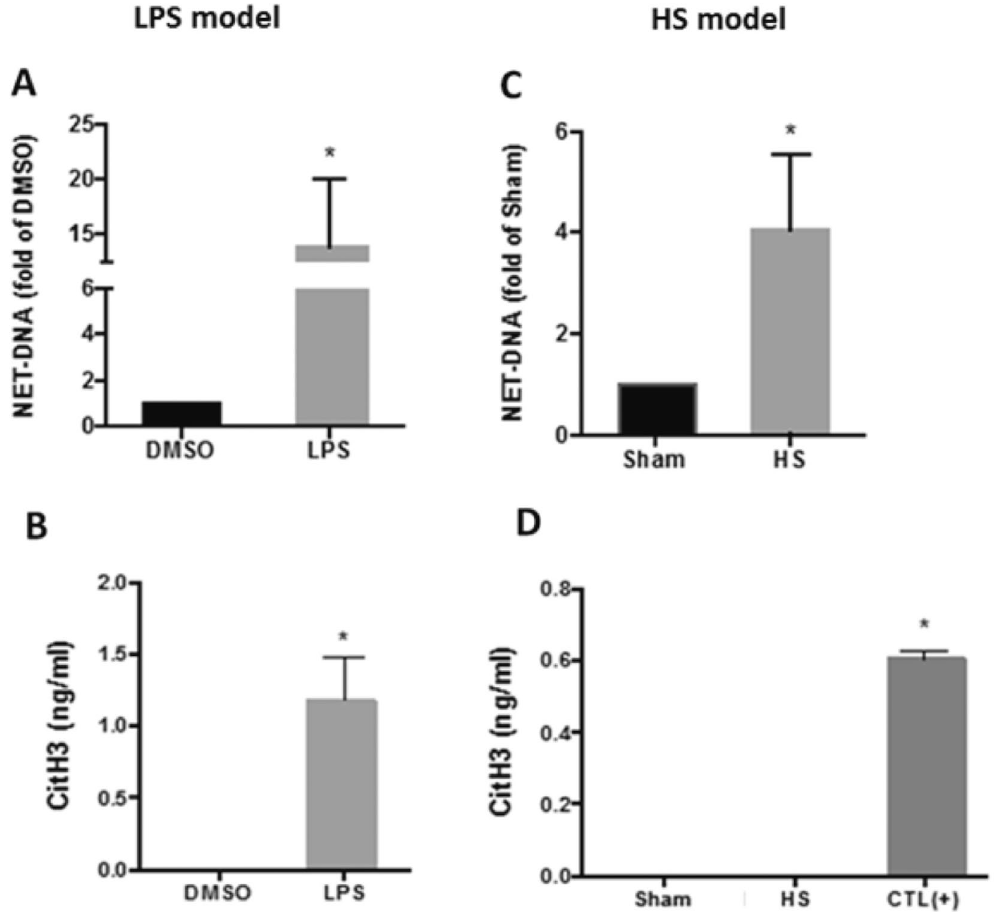
Figure 1. NETs formation is induced by both LPS and HS. Animals were intraperitoneally administrated LPS (35 mg/kg) ( A and B ) or received hemorrhage (30% blood loss) without any treatment ( C and D ). Animals from Sham group received all procedures except cannulation and hemorrhage. CitH3 protein serves as a positive control in panel D. Blood samples were harvested 12 hours post LPS or HS. The double stranded DNA ( A and C ) was dramatically elevated after LPS and HS insult compared to DMSO and Sham group, respectively. CitH3 was significantly increased after LPS insult ( B ) while was un-detectable after HS ( D ). Data are shown as mean ± standard deviation (SD) (n = 4–6/group). CitH3: Citrullinated histone H3; LPS: Lipopolysaccharide; DMSO: dimethyl sulfoxide; HS: hemorrhagic shock; NET: neutrophil extracellular trap; DNA: deoxyribonucleic acid. CTL ( + ): positive